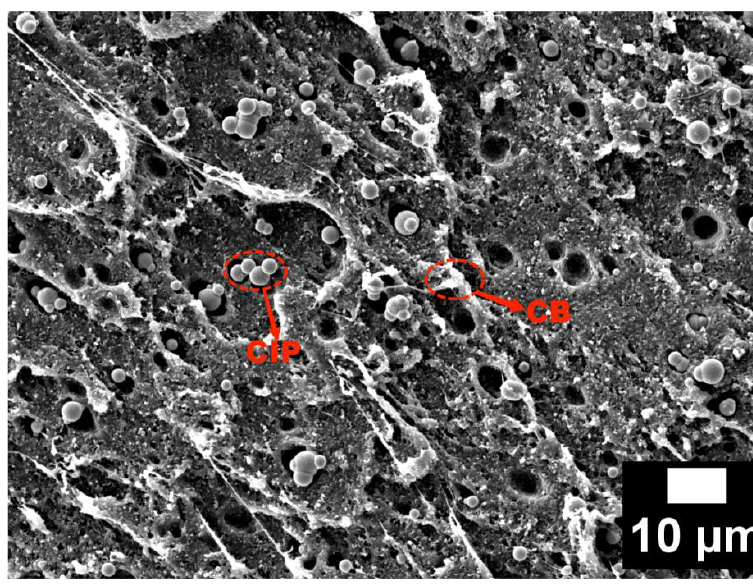
Figure 8. SEM micrographs of the CB20 − CIP30 composite.